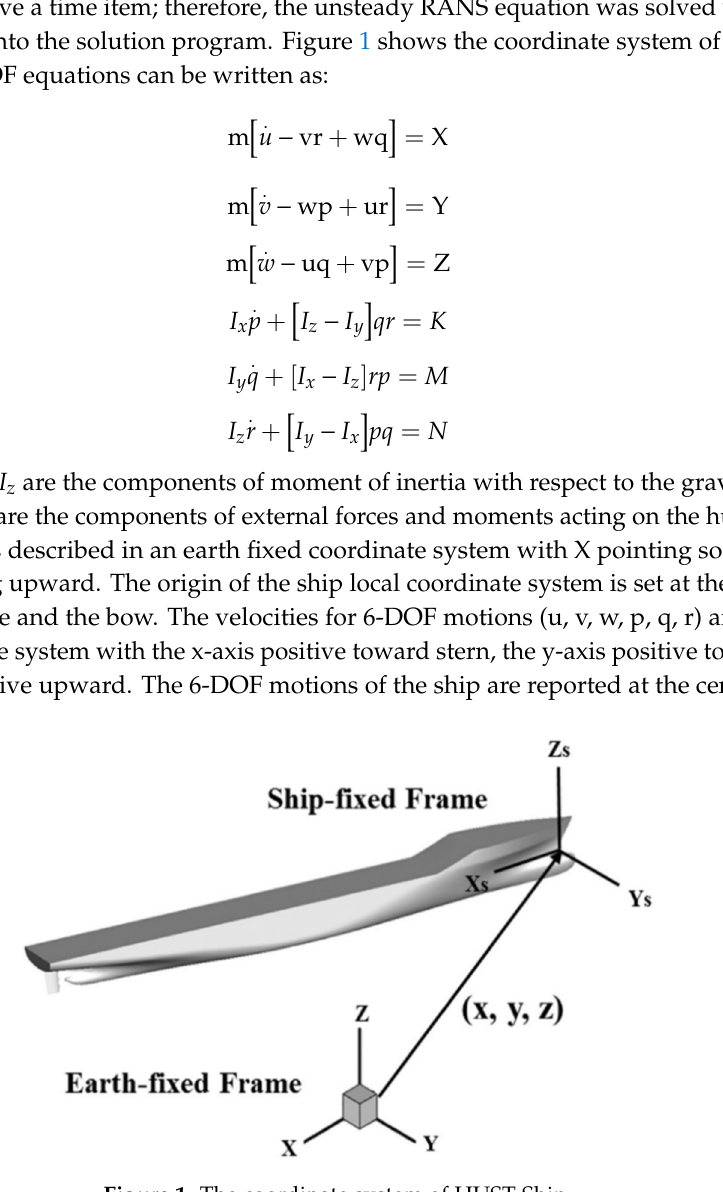
Figure 1. The coordinate system of HUST-Ship.